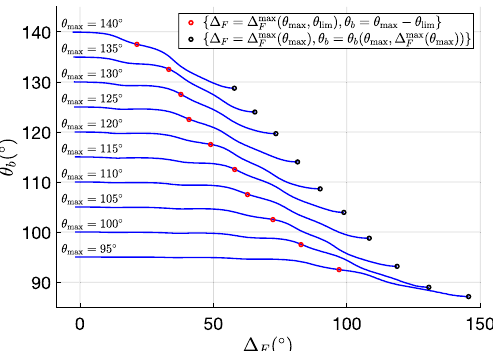
32 antenna elements and a maximum drift =